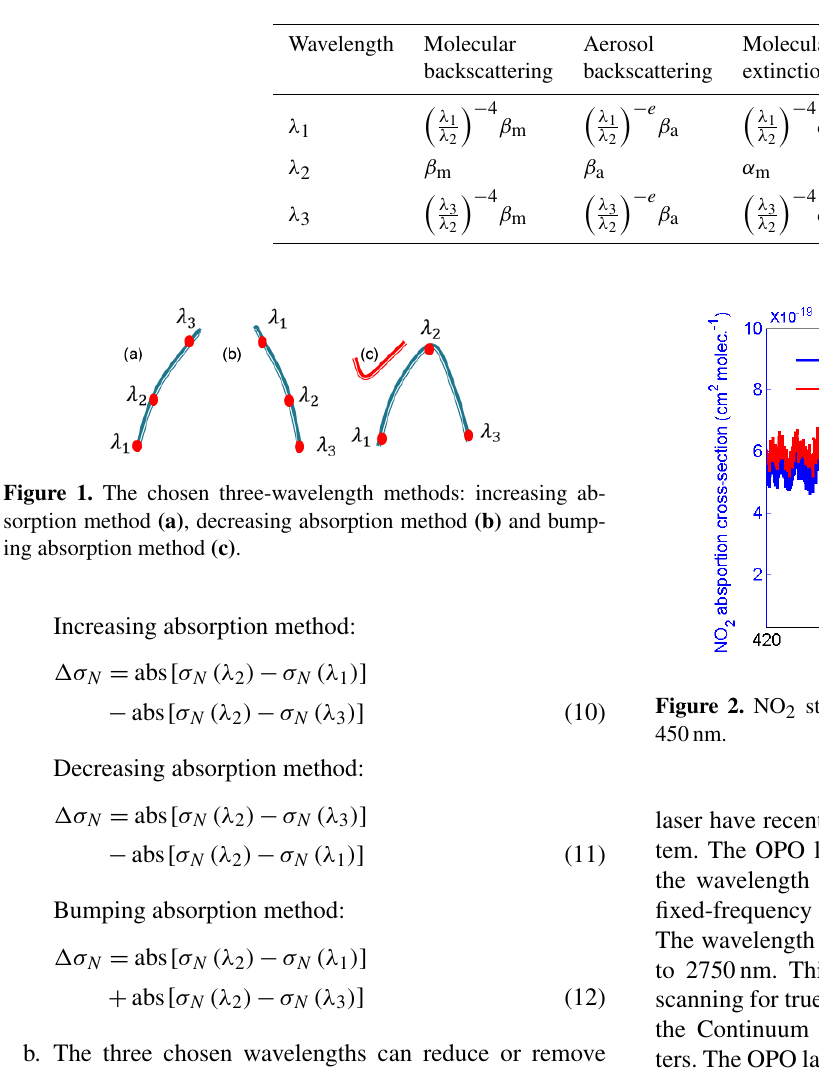
Table 1. Extinction and backscatter of molecule and aerosol for wavelengths of λ 1 , λ 2 and λ 3 .